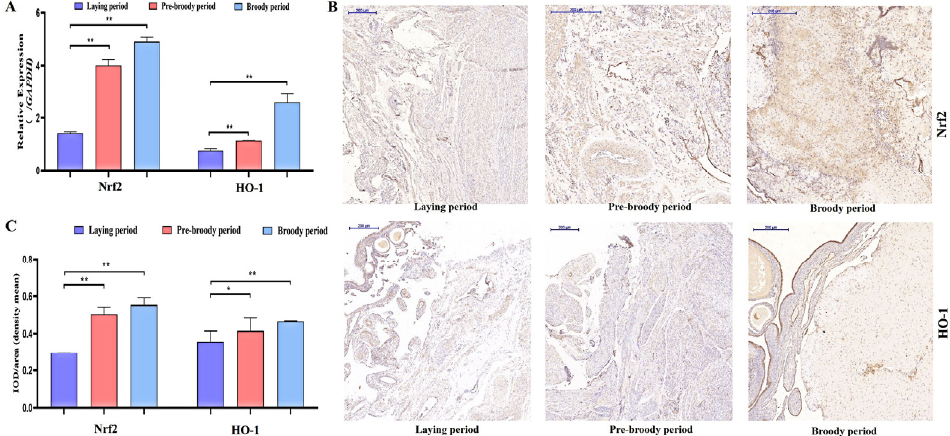
Figure 4. Analysis of oxidation indices of goose ovaries. ( A ) Expression of Nrf2 and HO-1 in the ovaries of geese during different periods ( n = 3). The values show the means ± standard errors of all experiments. Asterisks indicate significant differences (** p < 0.01). ( B ) Immunohistochemical staining of Nrf2 and HO-1. Scale bar = 200 μ m. ( C ) Quantitative analysis of immunohistochemical staining of Nrf2 and HO-1 based on the mean density shown in ( B ) ( n = 5); * p < 0.05; ** p < 0.01.